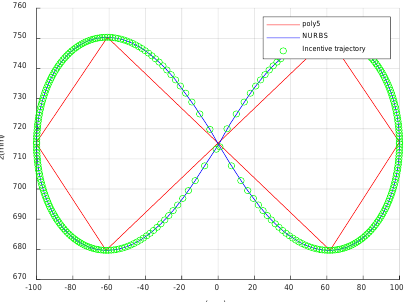
Figure 11. NURBS and five-order polynomial. According to the trajectory planning process in Figure 5, the displacement, velocity and acceleration curves of each joint planned by the algorithm in this paper could be obtained, as shown in Figure 12.